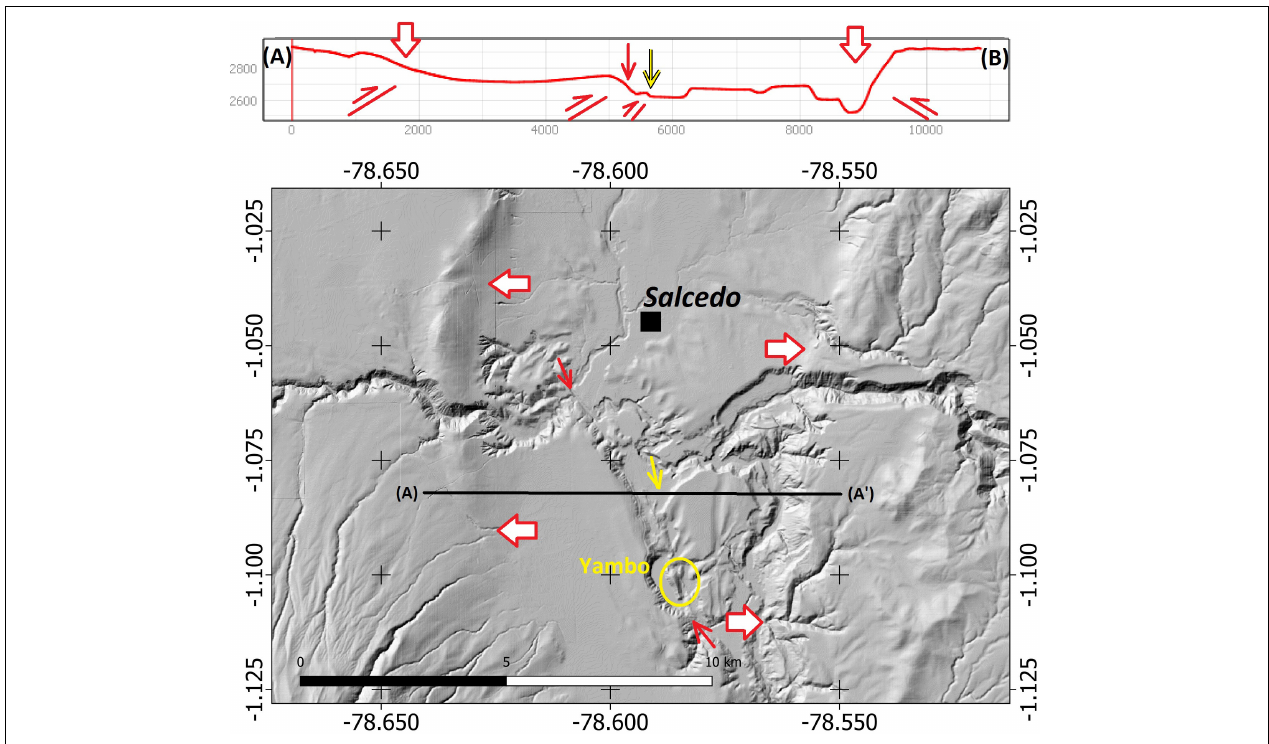
FIGURE 10 | North of the strike-slip fault sections in the Inter-Andean Valley, the fault-related folds and flexures around Ambato and Latacunga cities are clearly exposed in topography. (A,B) illustrates a topographic profile across those fault-related folds and flexures, suggesting a reverse component along near surface dip slip faults. Reverse faults have been observed in places between Quaternary volcanic deposits (e.g., between the Chalupas ignimbrite, 215 ka old according to Bablon et al., 2019, and the Latacunga series) and some symmetrical folds (e.g., Yambo laguna) clearly impact the landscape